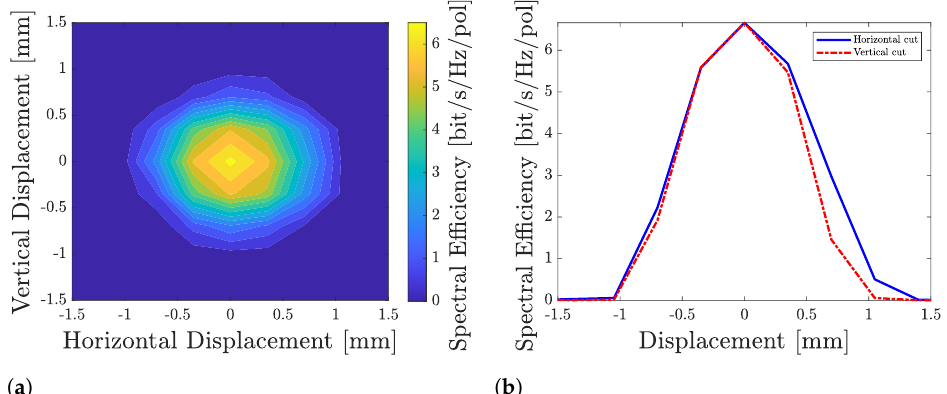
Figure 13. (a ) SSMF contour map of spectral efficiency at the Rx for the different beam focus. ( b ) SSMF respective spectral efficiency of beam